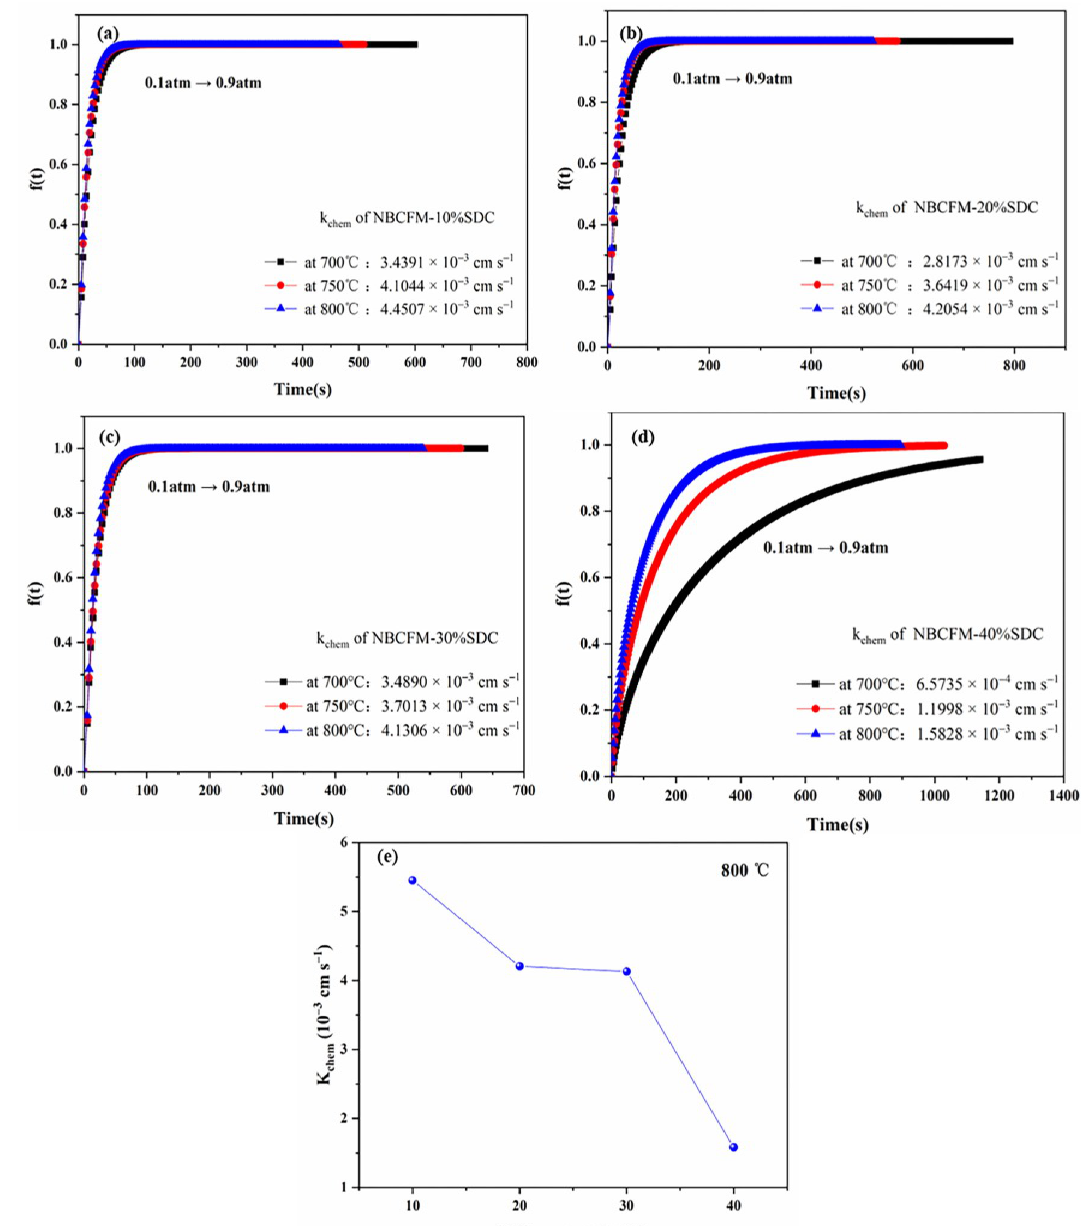
Figure 5. Conductivity relaxation plots of ( a ) NBCFM-10%SDC, ( b ) NBCFM-20%SDC, ( c ) NBCFM- 30%SDC and ( d ) NBCFM-40%SDC at 700 ◦ C, 750 ◦ C and 800 ◦ C; variation of ( e ) k chem of NBCFM- x SDC with SDC